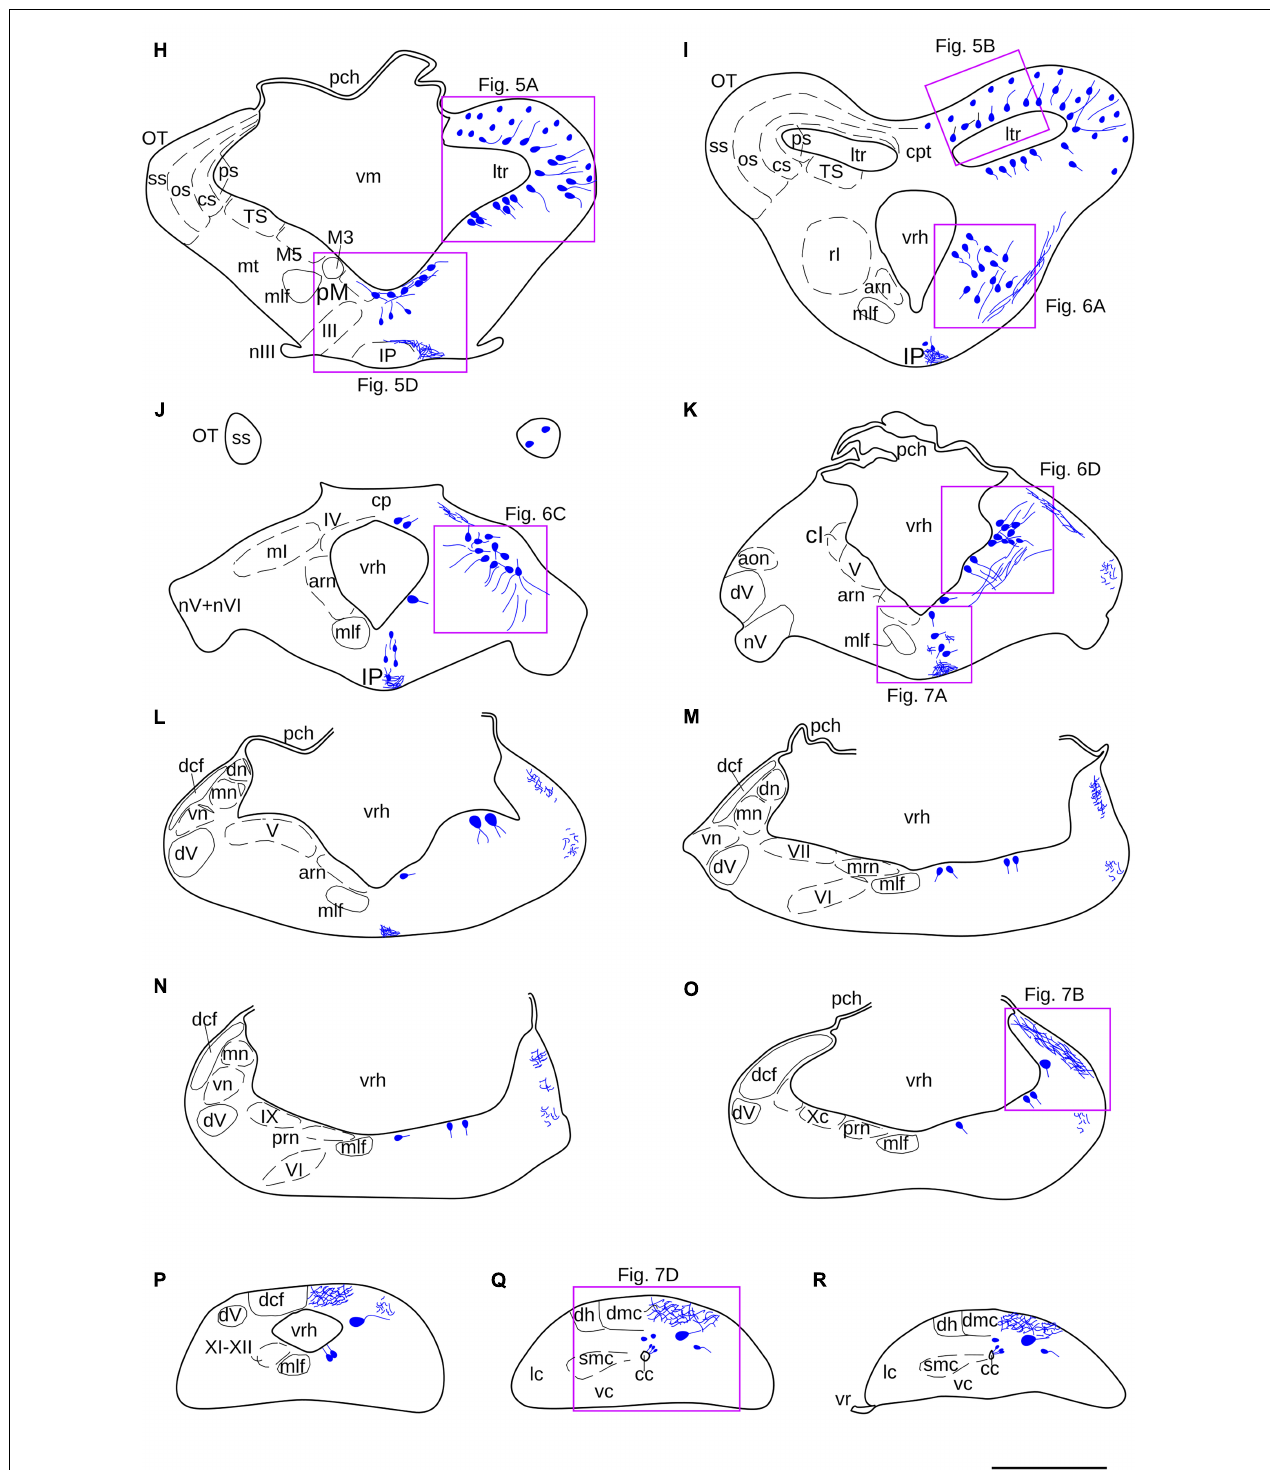
FIGURE 2 | (A–R) Schematic drawings of a series of transverse sections through the brain and rostralmost spinal cord of L. fluviatilis , at the rostrocaudal levels indicated in Figure 1 . The distribution of NADPH-d positive cell bodies (large blue dots) and fibers (small blue dots, wavy blue lines) are represented in the right half of each section, whereas some cell populations and specific regions or fiber tracts are represented in the left half. The relative location of the transverse illustrations shown in Figures 3–7 are indicated by purple rectangles. For abbreviations, see list. Scale bar = 1 mm.